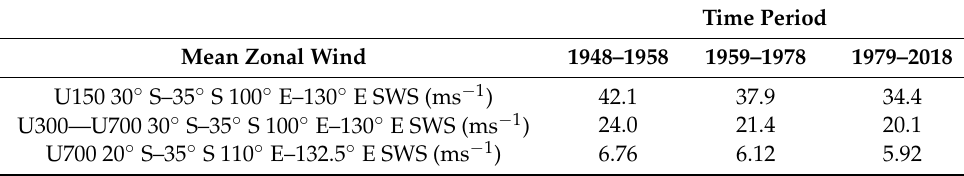
Figure 5. Interannual variability of April–November ( a ) 150 hPa zonal wind averaged between 30 ◦ S and 35 ◦ S, 100 ◦ E and 130 ◦ E and ( b ) 300 hPa minus 700 hPa zonal wind shear averaged between 30 ◦ S and 35 ◦ S, 100 ◦ E and 130 ◦ E. Table 4. The mean April–November (SWS) 150 hPa zonal wind averaged between 30 ◦ S and 35 ◦ S, 100 ◦ E and 130 ◦ E, 300 hPa minus 700 hPa zonal wind shear averaged between 30 ◦ S and 35 ◦ S, 100 ◦ E and 130 ◦ E, and 700 hPa zonal wind averaged between 20 ◦ S and 35 ◦ S, 110 ◦ E and 132.5 ◦ E, for different time periods.